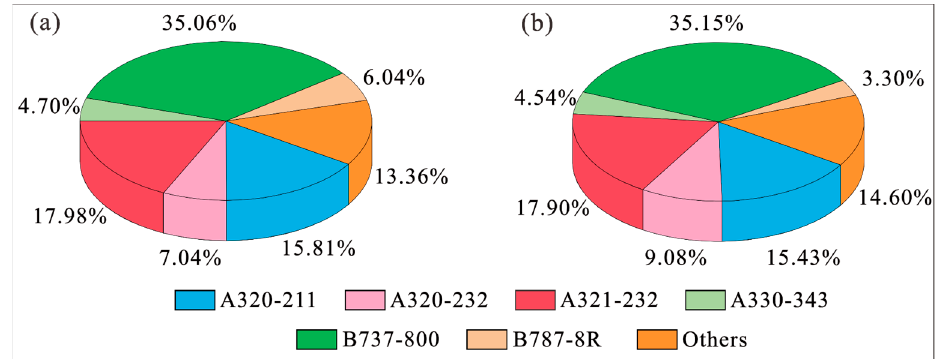
Figure 1. Proportions of the aircraft types that take off and land at BIA during ( a ) summer and ( b ) winter [28].